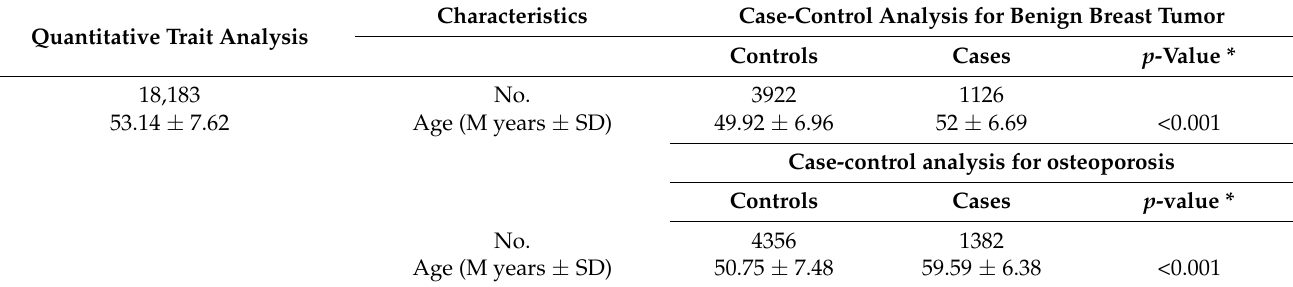
Table 1. Characteristics of women in the Health Examinee (HEXA) study cohort. Quantitative Trait Analysis